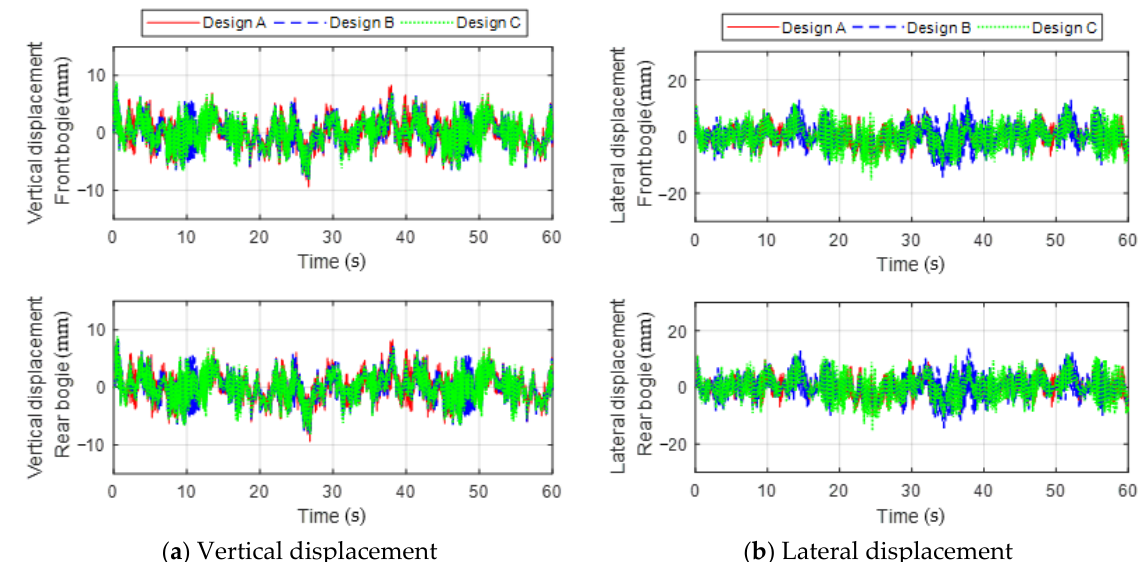
Figure 18. Vertical and lateral displacements of the front and rear bogies at a speed of 300 km/h.